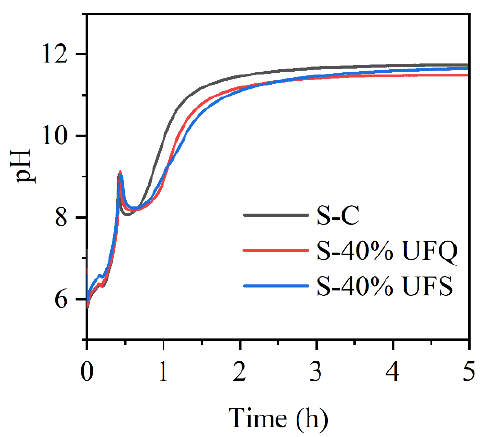
Figure 9. pH curves of the suspensions with ultrafine quartz or slag.